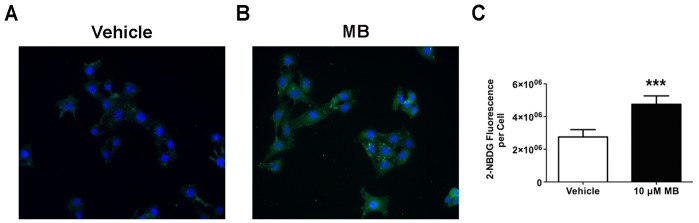
MB increases glucose uptake in HT-22 cells.Representative live cell images show glucose uptake in (A) vehicle- and (B) MB-treated HT-22 cells. (C) Quantitative analysis indicates a significant increase of glucose uptake upon MB treatment at 10 µM. Data are mean ± SD; ***, p<0.001.